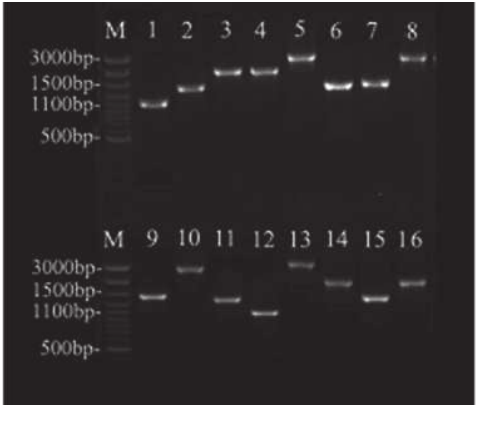
Fig. 1. – Quality control of the cDNA library after freezing and sto- rage at – 80° C. PCR analysis of cDNA inserts from the adult worm cDNA library was performed randomly. M: molecular weight marker 100 bp ladder. Lanes 1-16: cloned inserts from the adult cDNA